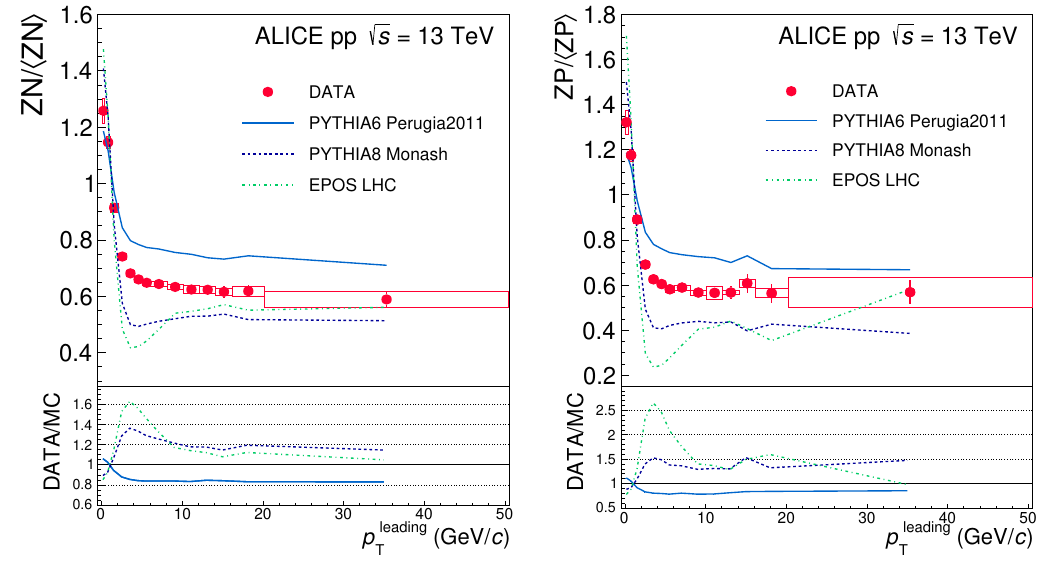
Figure 9 . Self-normalised ZN (left) and ZP (right) signals as a function of the leading particle √ p T measured in | η | < 0 . 8 in pp collisions at s = 13 TeV. Data (red markers) are compared to PYTHIA 6 (blue solid line), PYTHIA 8 (blue dashed line) and EPOS LHC (green dotted